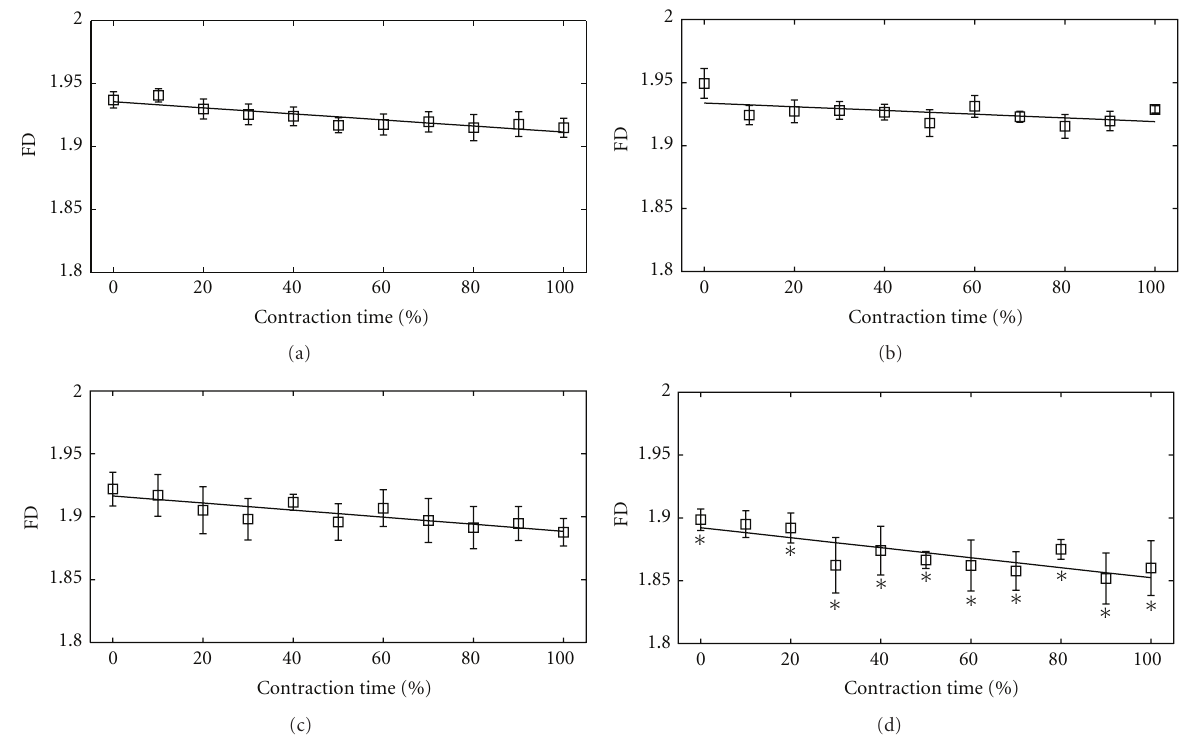
Figure 3: The changes of mean FD ( ± SE) over the normalized contraction time during the prefatigue (a) and refatigue (b) tasks of the LEDT group and the prefatigue (c) and refatigue (d) tasks of the passive rest group. The symbol “ ∗ ” indicates that the di ff erence between the mean FD values of the two groups in the corresponding normalized contraction time is statistically